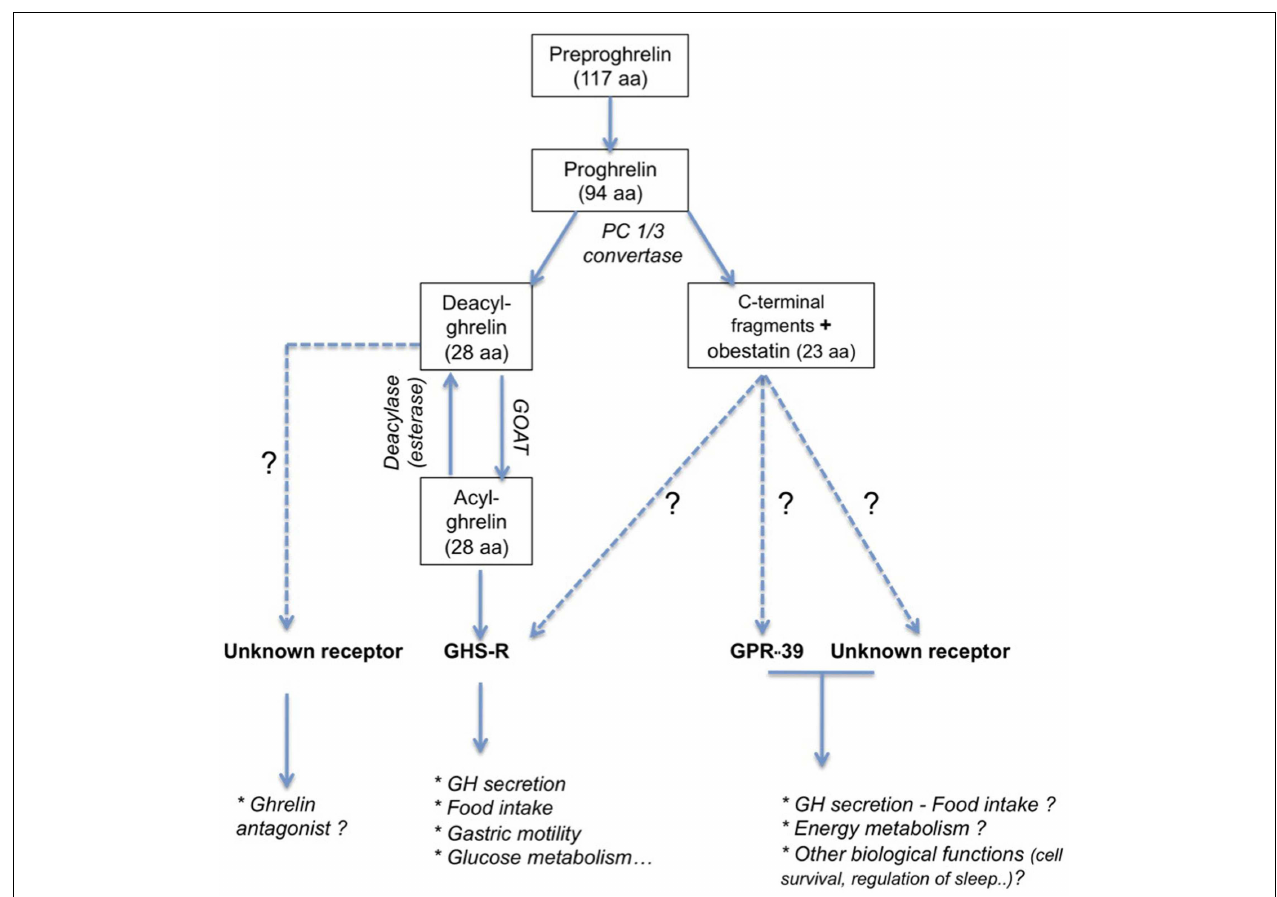
of food intake, ghrelin is also implicated in numerous biological function (see Veldhuis and Bowers, 2010).The active form of ghrelin, acyl ghrelin, is obtained by octanoylation of deacyl ghrelin. Its receptor is not yet identified and its function is currently unclear even if some evidences support an antagonistic effect to ghrelin (see Delhanty et al.,